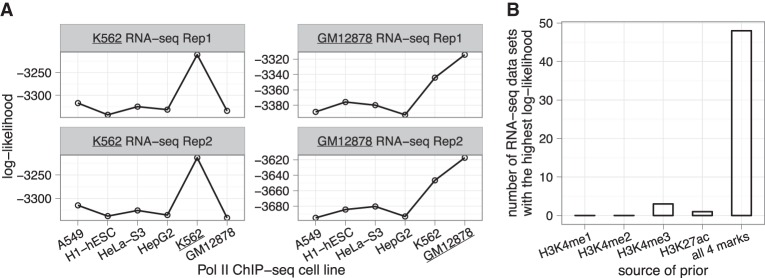
Informative priors for pRSEM can be derived from a broad range of data types. (A) Comparison of training set log-likelihoods based on isoforms partitioned by Pol II ChIP-seq peaks from six human cell lines. Log-likelihoods were computed by fitting pRSEM's Dirichlet-multinomial model to RNA-seq fragment counts of the partitioned training set isoforms. (B) Comparison of five sources of prior information by their effectiveness on 52 RNA-seq data sets of mouse hematopoietic cells. For each RNA-seq data set, all five sources were separately applied to fit the training set and the goodness of fit was assessed via the log-likelihood. The source resulting in the largest log-likelihood was considered to be the most effective. “All 4 marks” denotes a pRSEM partition model utilizing all four types of histone modification signals.